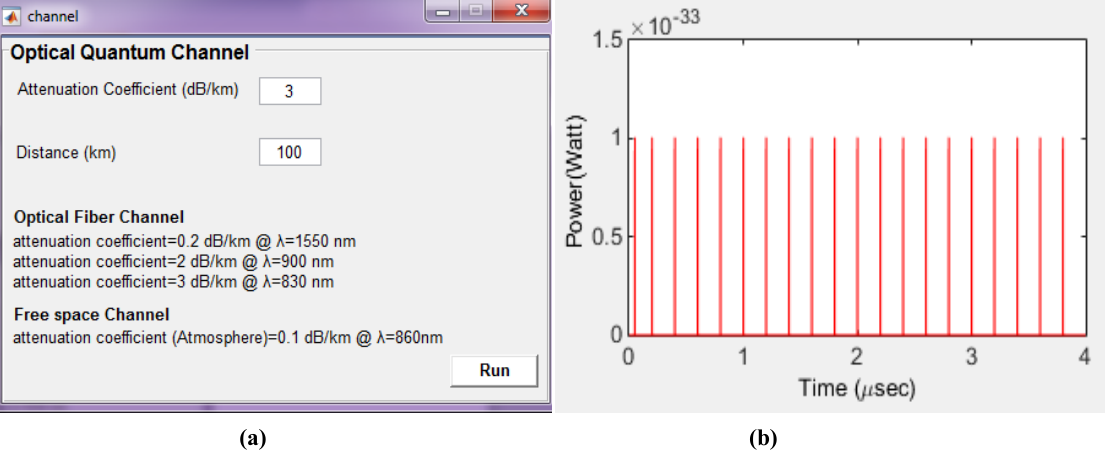
Fig. 8. Test 3 (a) GUI set up (b) result for for OF quantum channel for L=100km and α_p=3